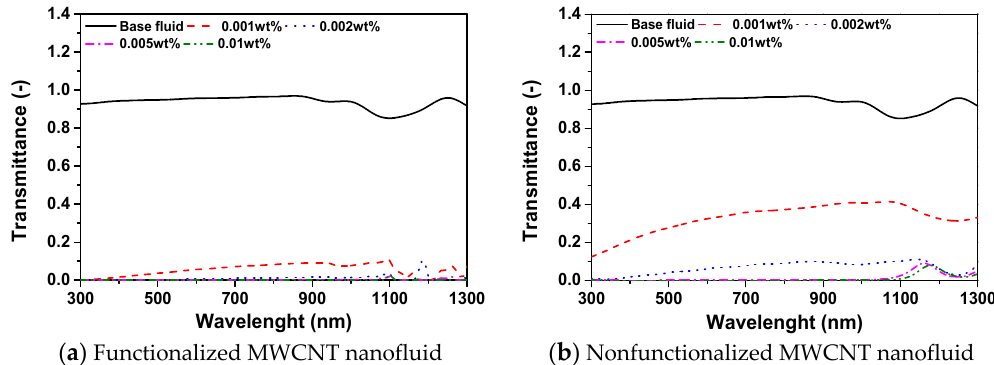
Figure 6. Variation of optical transmittance of ( a ) functionalized and ( b ) nonfunctionalized MWCNT nanofluid.